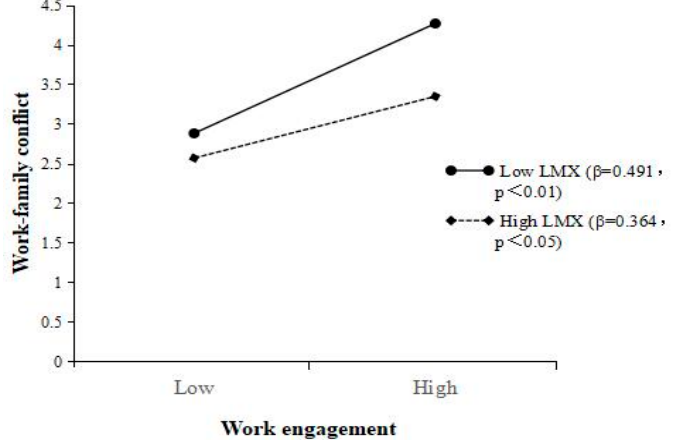
Figure 2. Interactive e ff ects of work engagement and LMX on work–family conflict.